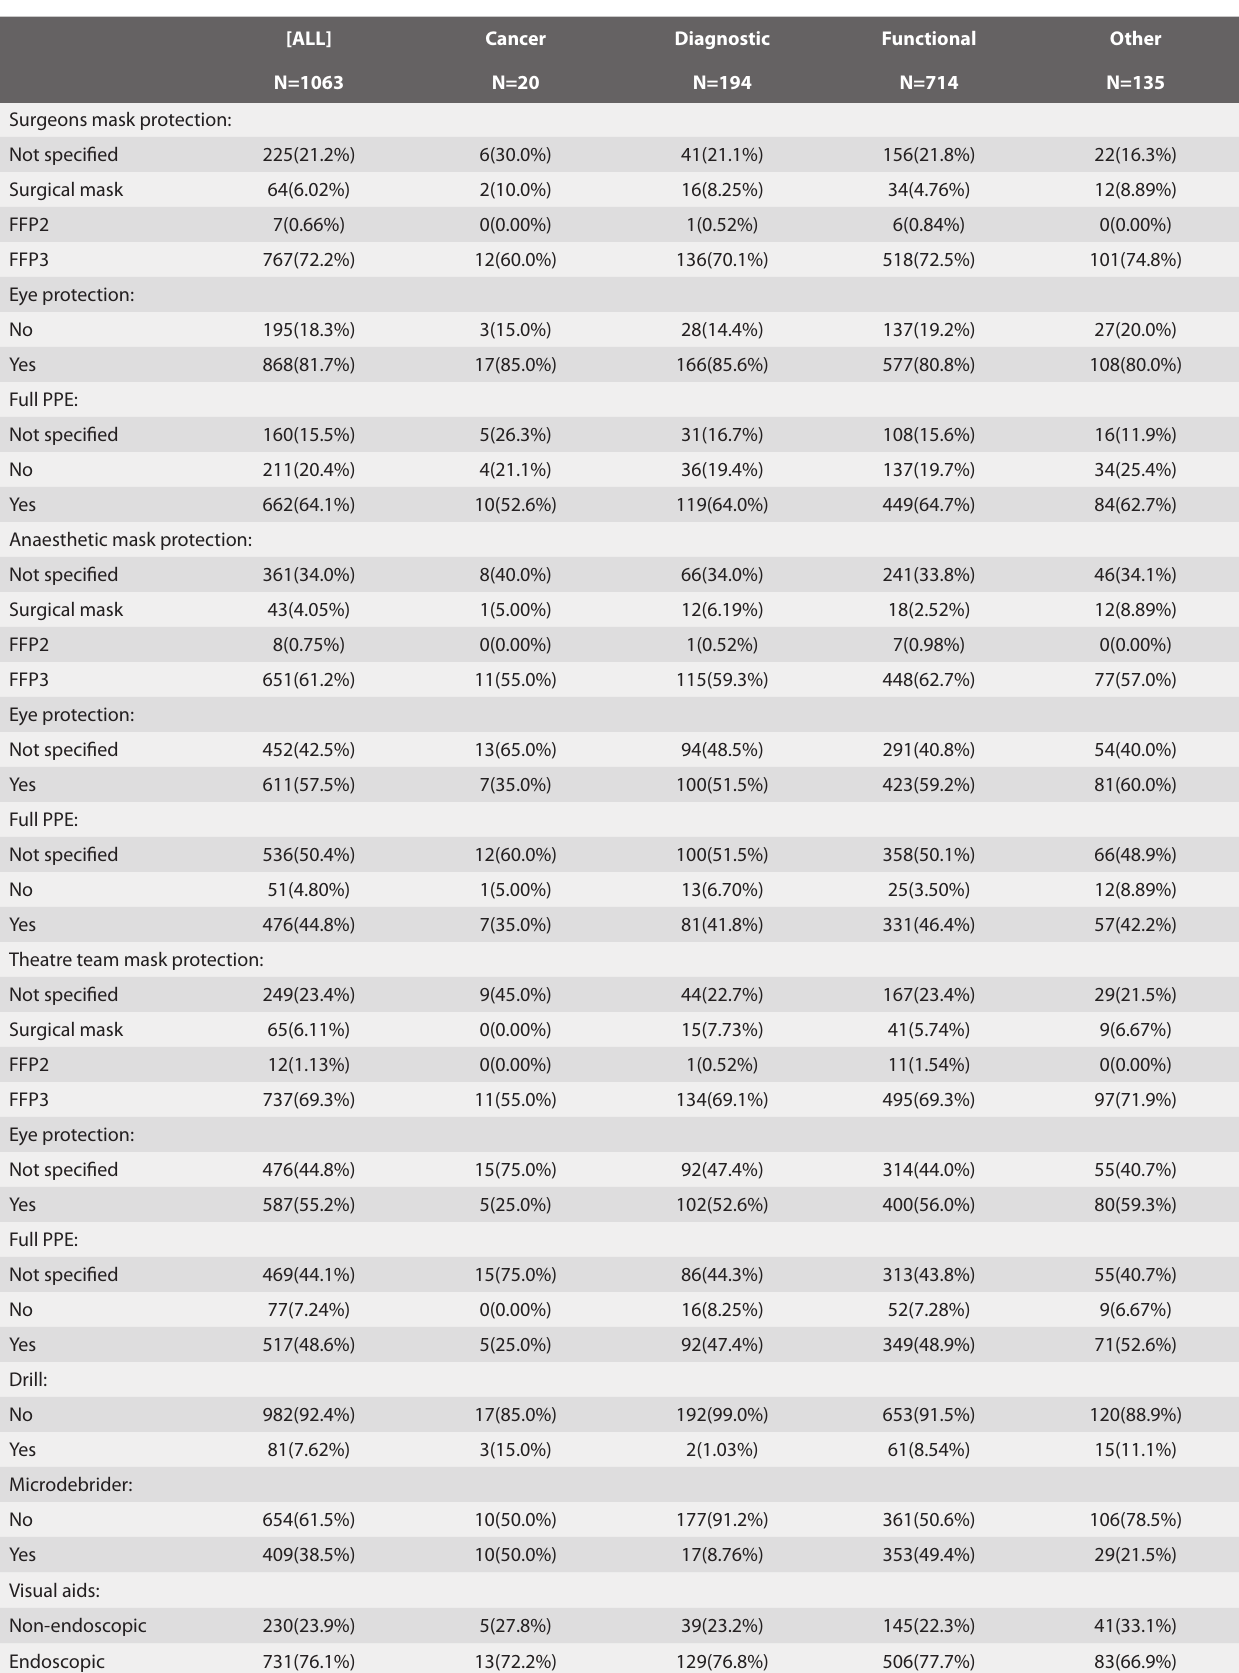
Table 5. Personal protective equipment and utilisation of powered instrumentation. [ALL] Cancer Diagnostic Functional Other N=1063 N=20 N=194